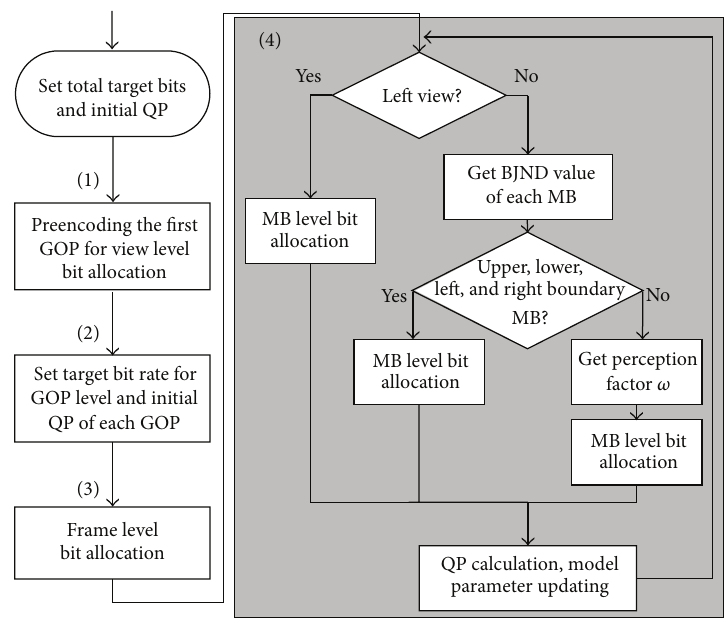
Figure 1: The framework of the proposed MB level rate control method for stereo video coding.